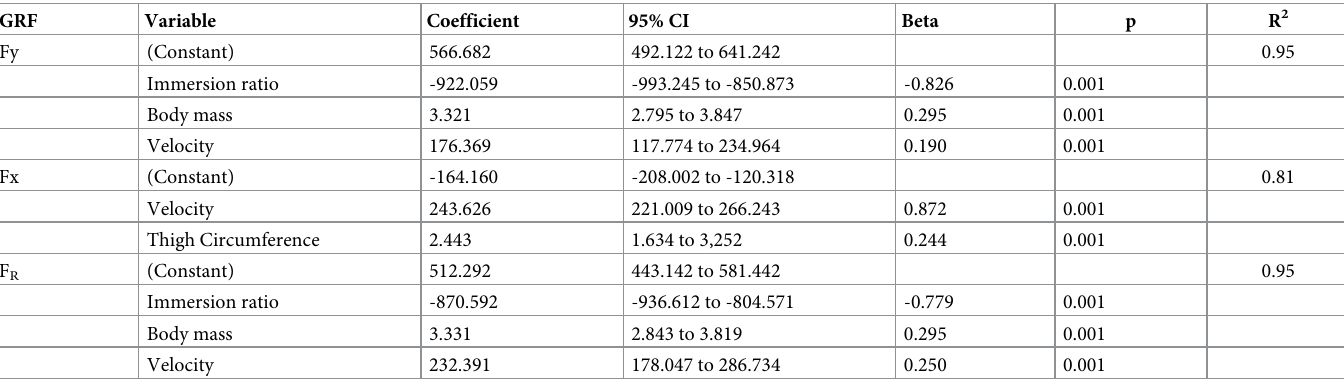
Table 3. Estimated of the multiple regression analysis for the prediction of vertical (Fy), antero-posterior (Fx) and resultant (F R ) of ground reaction force. GRF